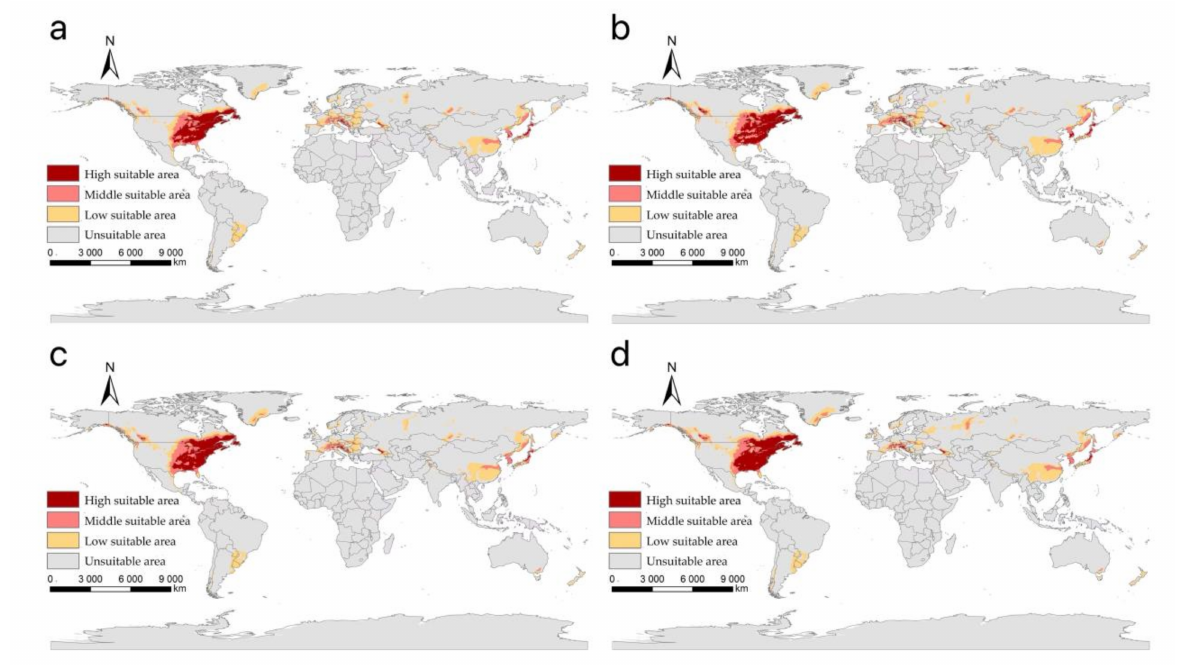
Figure 6. The suitable areas of I. scapularis around the world under shared socioeconomic pathway 3–7.0 (regional rivalry and forcing of 7.0 W/m 2 to 2100) during different periods of the 21st century: